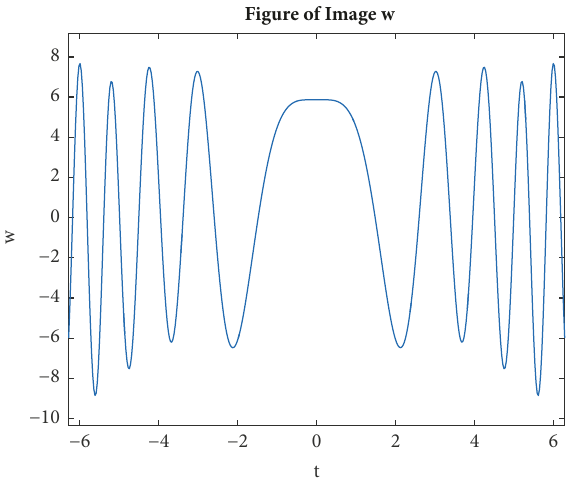
Figure 5: 𝑥 = 0.9 , 𝑙 1 = 0.3 , 𝑙 2 = 0.5 , 𝑙 3 = 0.8 , 𝑚 1 = 1 , 𝑚 2 = 2 , 𝑦 = 3 , and 𝑡 ∈ [−6,6]